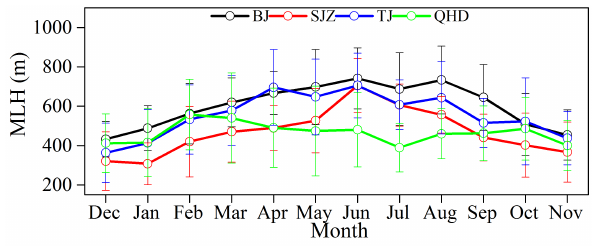
Figure 3. Monthly variations of MLH at the BJ, SJZ, TJ and QHD stations from December 2013 to November